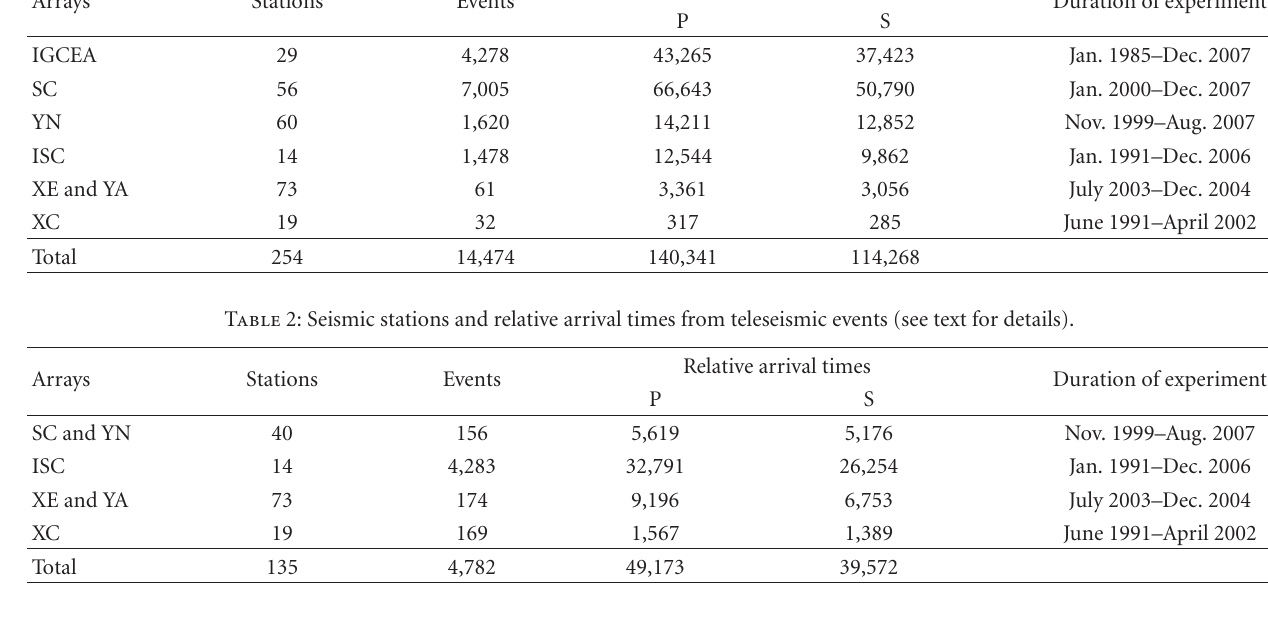
Table 1: Detailed information on the local-earthquake arrival-time data and seismic arrays (see text for details). Arrays